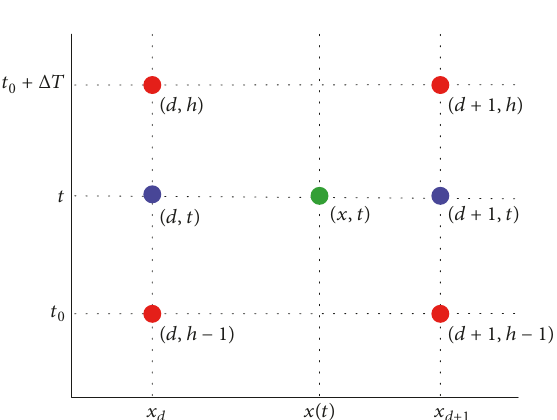
Figure 10: Principle of two-dimensional linear interpolation meth-